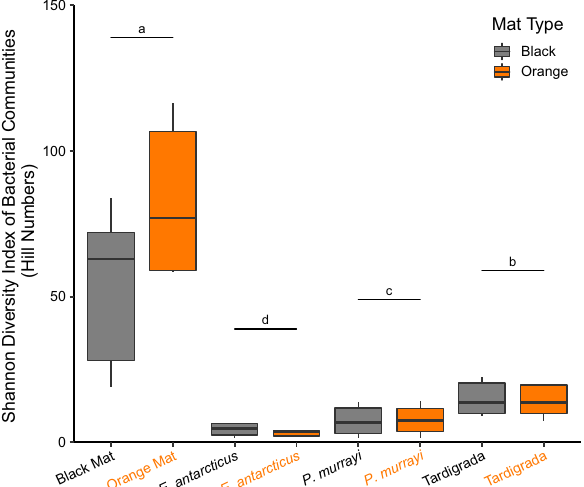
Figure 2. Bacterial ASV Shannon diversity (Hill Numbers) of microbial mats and microinvertebrate gut microbiomes from black and orange mats. Horizontal lines and letters indicate significant difference ( P < 0.05) among the eight communities with GLM and then Tukey